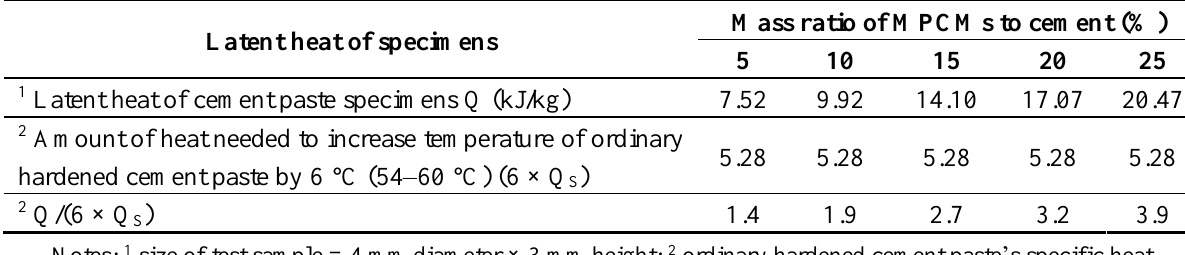
Table 2. Energy storage of specimens with different mass ratios of MPCM.